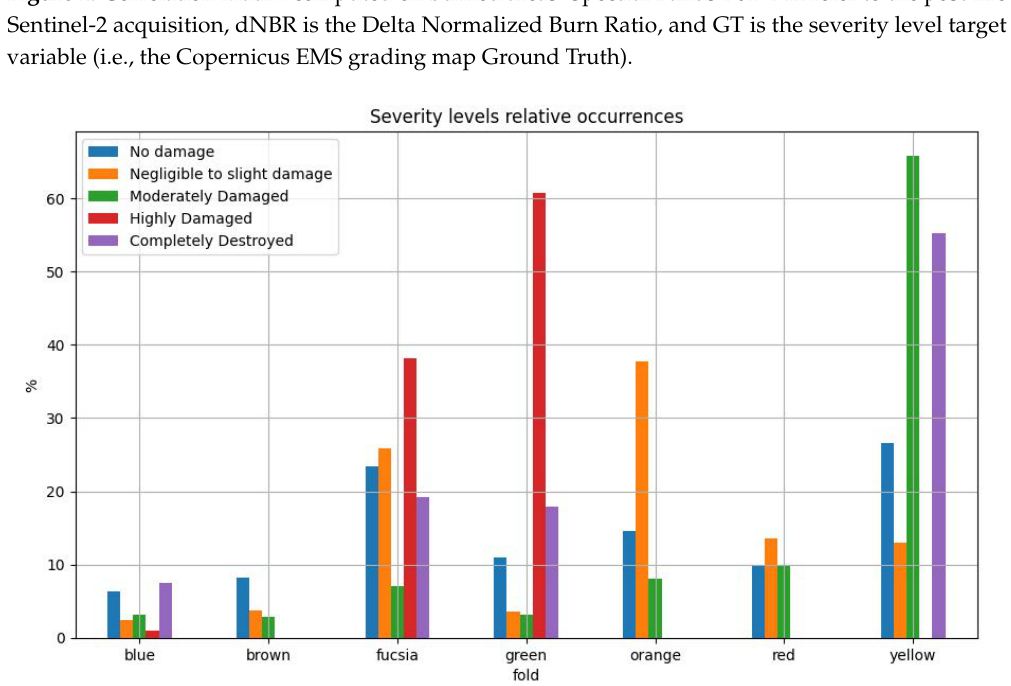
Figure 3. Severity level distribution among each fold. For each severity level, the percentage of pixels with the considered level is computed within each